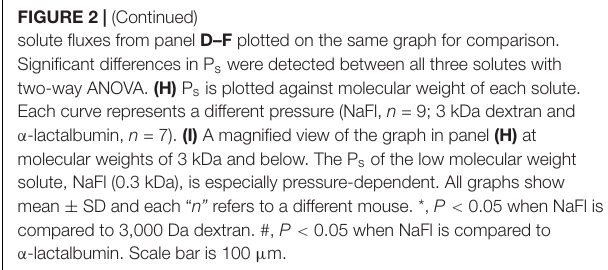
FIGURE 2 | (Continued) solute fluxes from panel D–F plotted on the same graph for comparison. Significant differences in P s were detected between all three solutes with two-way ANOVA. (H) P s is plotted against molecular weight of each solute. Each curve represents a different pressure (NaFl, n = 9; 3 kDa dextran and α -lactalbumin, n = 7). (I) A magnified view of the graph in panel (H) at molecular weights of 3 kDa and below. The P s of the low molecular weight solute, NaFl (0.3 kDa), is especially pressure-dependent. All graphs show mean ± SD and each “ n” refers to a different mouse. *, P < 0.05 when NaFl is compared to 3,000 Da dextran. #, P < 0.05 when NaFl is compared to α -lactalbumin. Scale bar is 100 µ